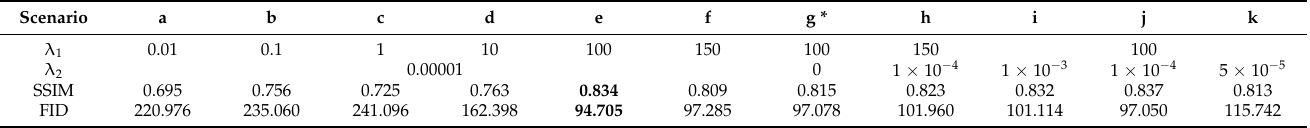
Table 3. Results of tuning-parameter scenarios.